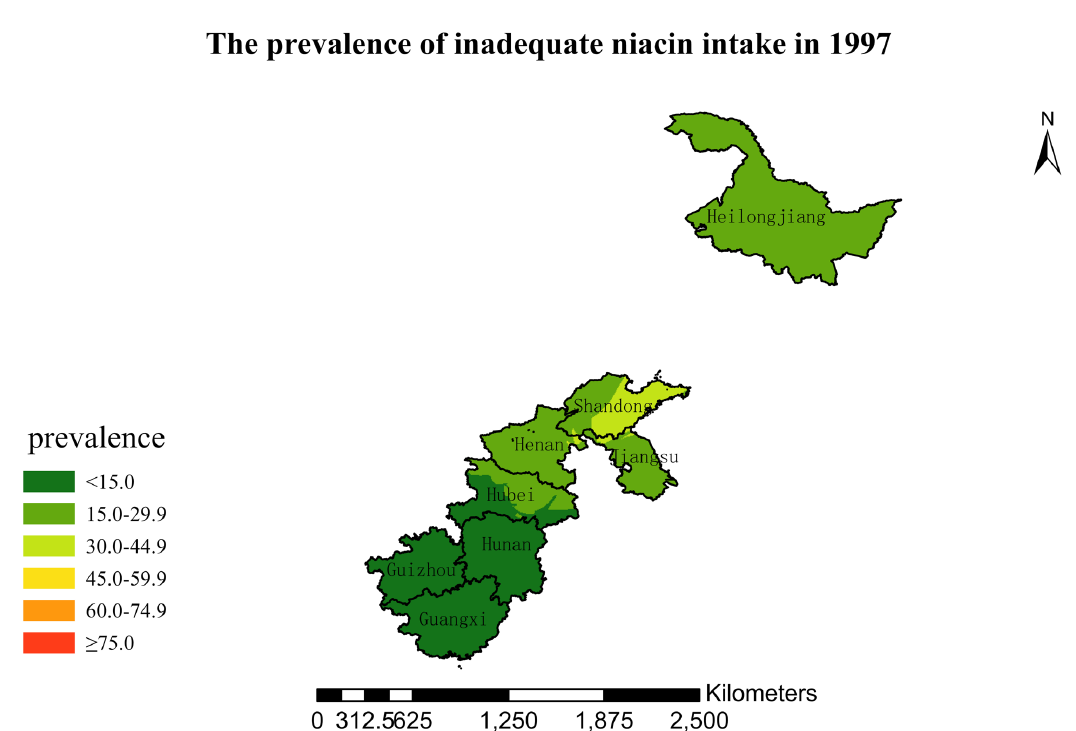
Figure 3. The prevalence of inadequate niacin intake by county in 1997 among Chinese Residents ≥ 5 Years of Age.